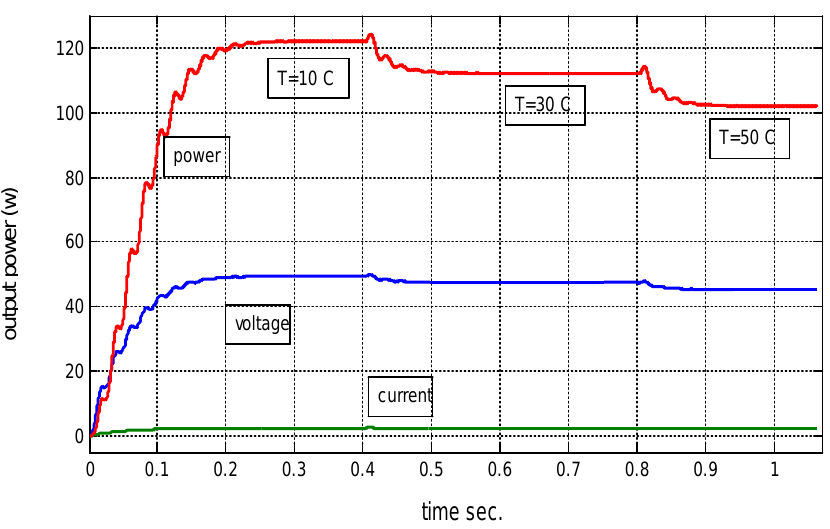
Figure 9. The boost converter output responses at G = 800 W / m 2